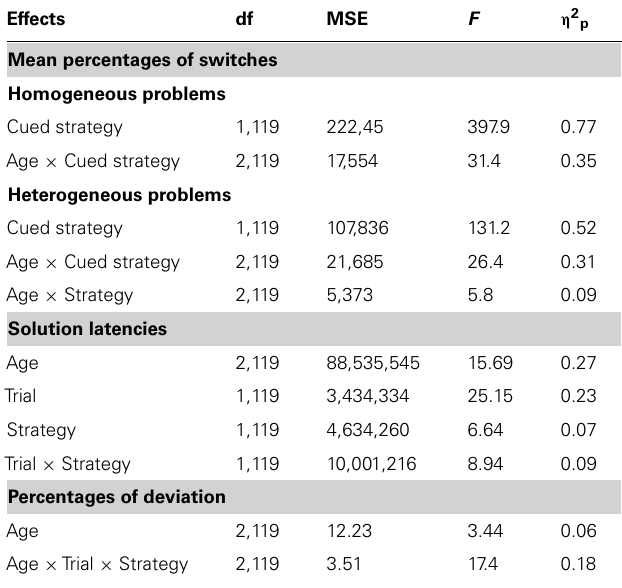
Table 2 | Statistics of significant effects for mean percentages of switches, solution latencies, and percentages of